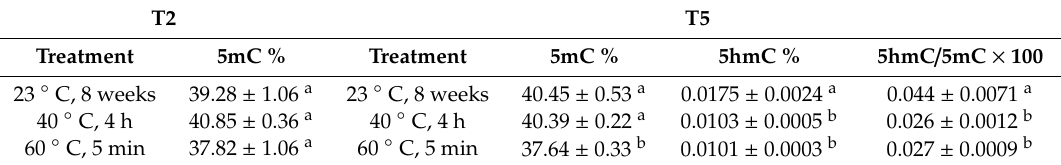
Table 1. Methylation and hydroxymethylation rates of Pinus radiata proliferating embryonal masses collected at T2 and needles of one-year-old somatic plants (T5) originating from megagametophytes cultured under di ff erent temperature treatments (23 ◦ C, 8 weeks; 40 ◦ C, 4 h; 60 ◦ C, 5 min). Data are presented as mean values ± SE. Significant di ff erences among treatments at p < 0.05 are indicated by di ff erent